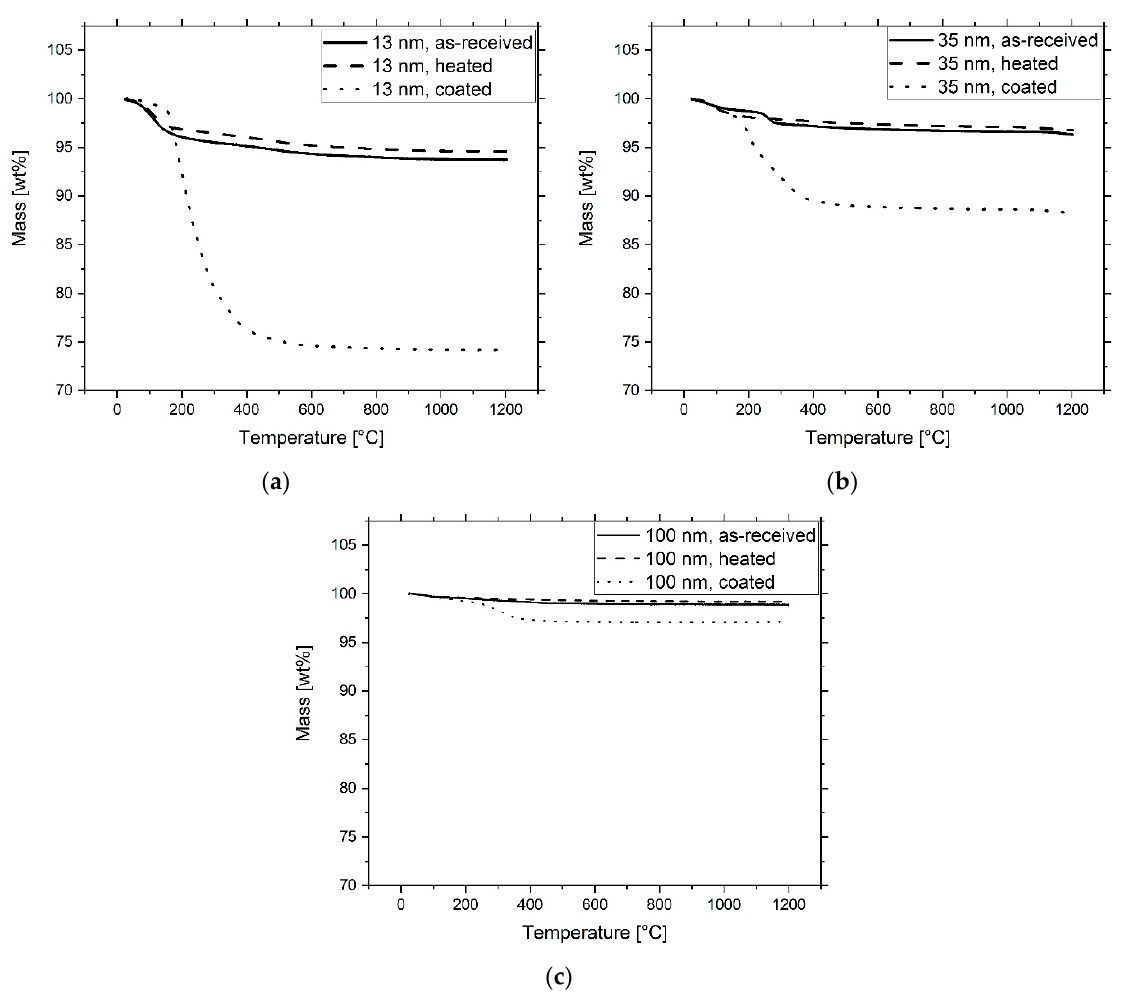
Figure 5. Thermogravimetric investigation of 13 nm ( a ), 35 nm ( b ) and 100 nm ( c ) as-received, heated and TODA coated filler particles. Table 2. Maximum mass loss of as-received, heated and coated fillers during thermogravimetric analysis. The weighted TODA concentration, i.e., the amount of dispersant added during ball milling, is related to the TODA concentration measured in the TGA.